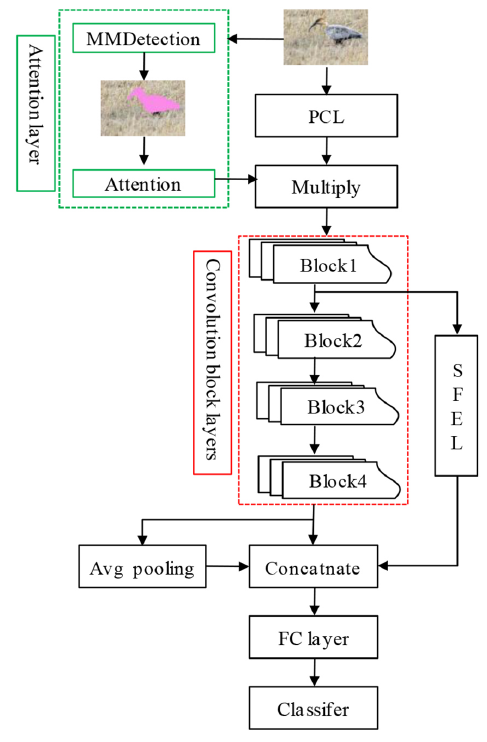
Figure 2. The architecture of AM-CNN model.